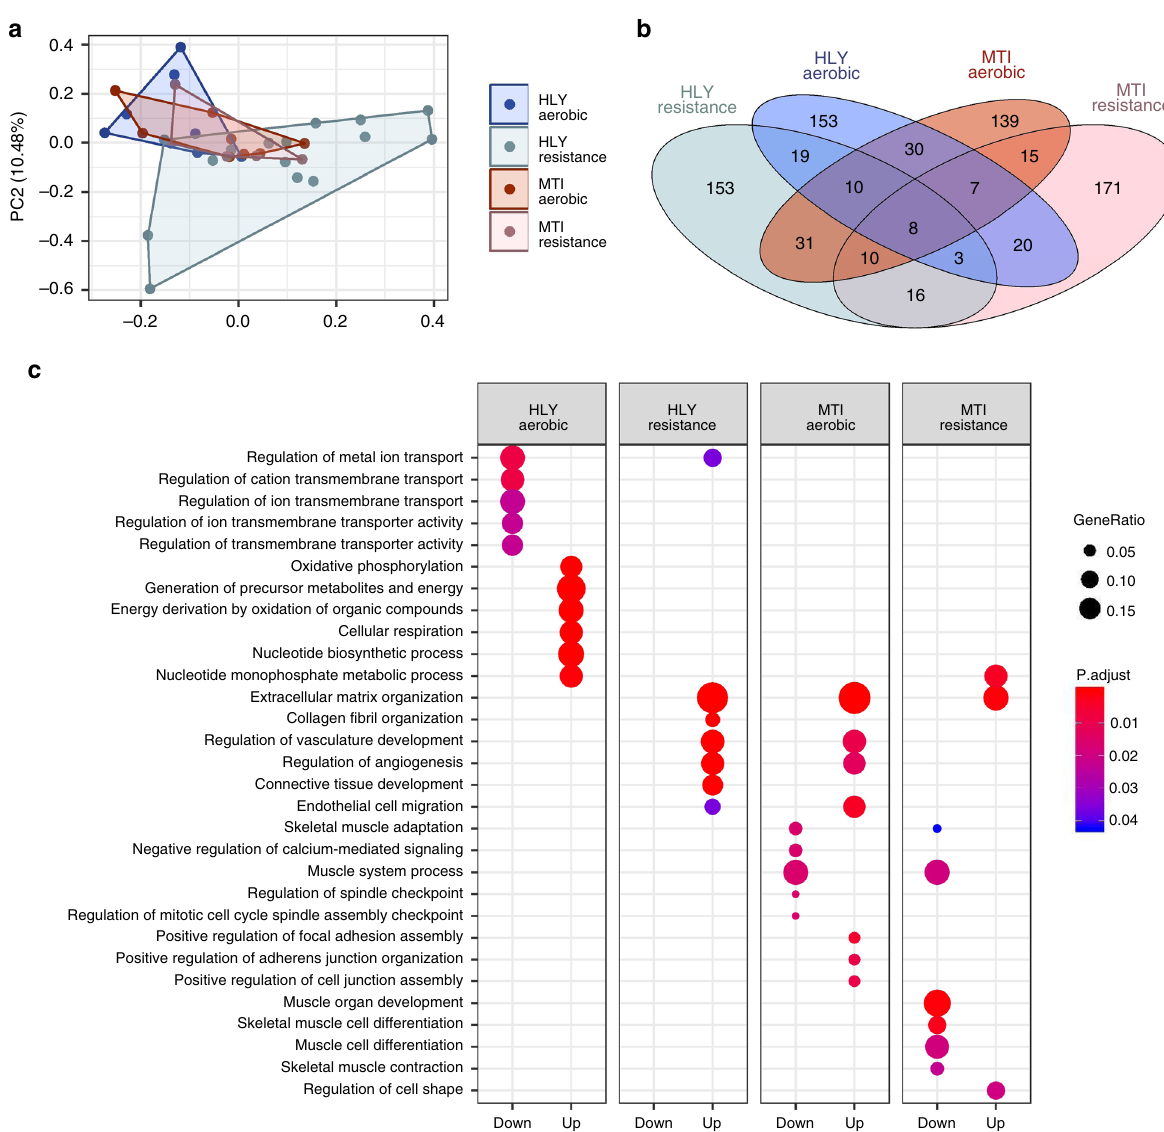
Fig. 6 Differential response to exercise training in metabolically impaired individuals. To compare healthy (HLY) to metabolically impaired (MTI) individuals, a principle component analysis was performed ( a ) and the signi fi cantly regulated genes (FDR < 0.1) overlapped in a Venn diagram ( b ). Gene ontology analysis calculated based on genes with FDR < 0.1 demonstrated a differential response of metabolically impaired individual to both aerobic and resistance training protocols ( c